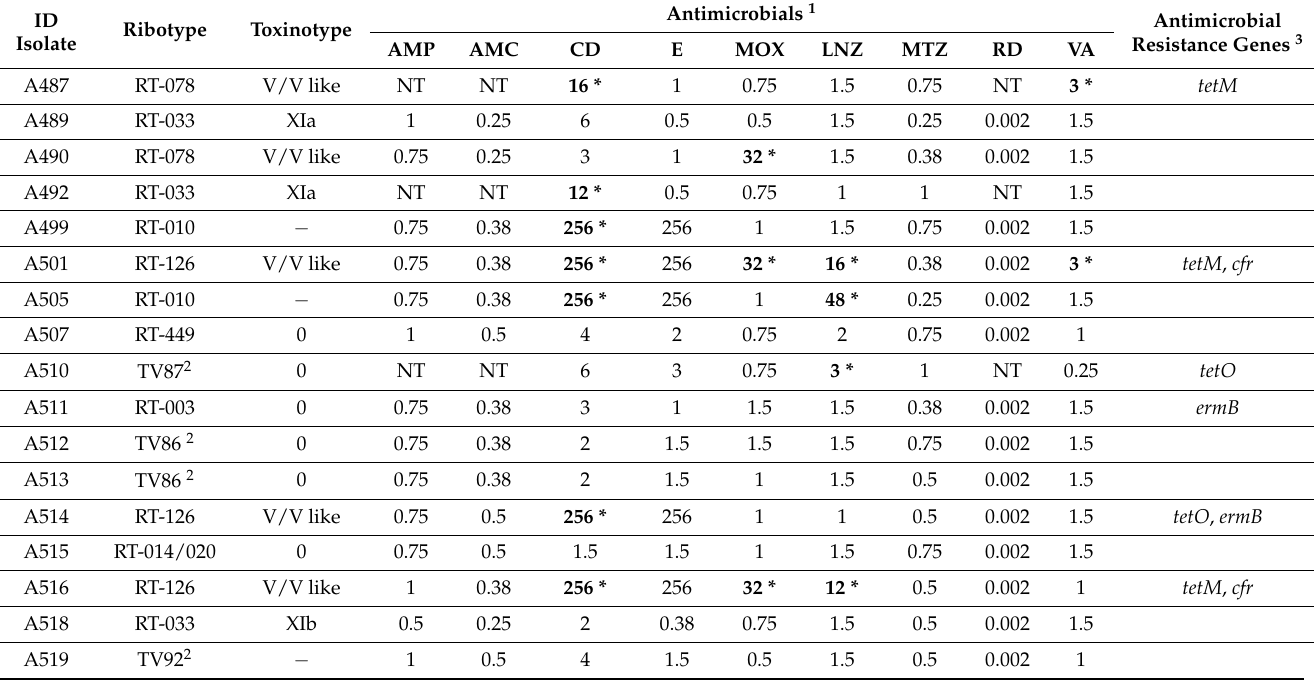
Table 4. Ribotype, toxinotype and antimicrobial susceptibility data of 17 C. difficile isolates, one per farm. ID Isolate